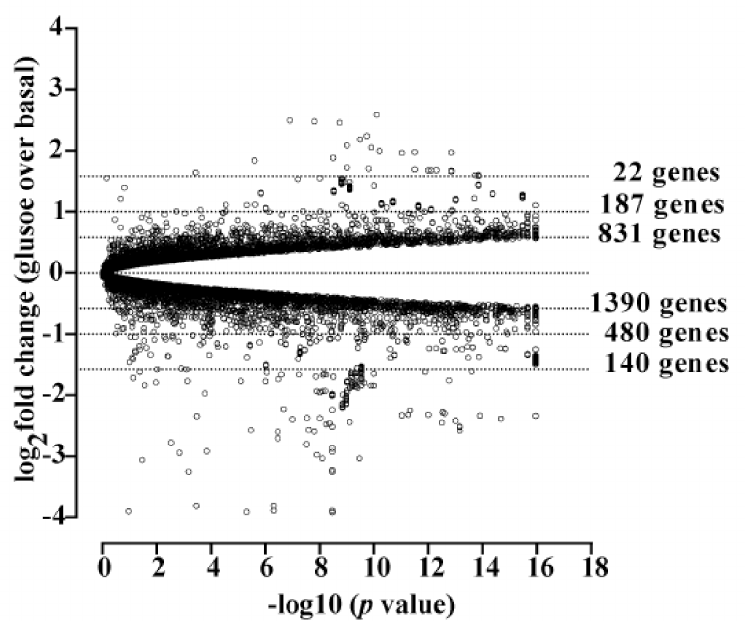
Figure 1. Volcano plot of RNA-seq data obtained with mHypoA-2/10 cells at low and high glucose levels. Cells were stimulated according to protocol 1 illustrated in Section 2.5. Only genes with RPKM of ≥ 1 for at least one condition (11,062 genes) are shown. The number of genes with a fold change of | FC | ≥ 3, | FC | ≥ 3, or | FC | ≥ 1.5 are given. For each condition, one single experiment performed in triplicate was analyzed as described under experimental procedures.